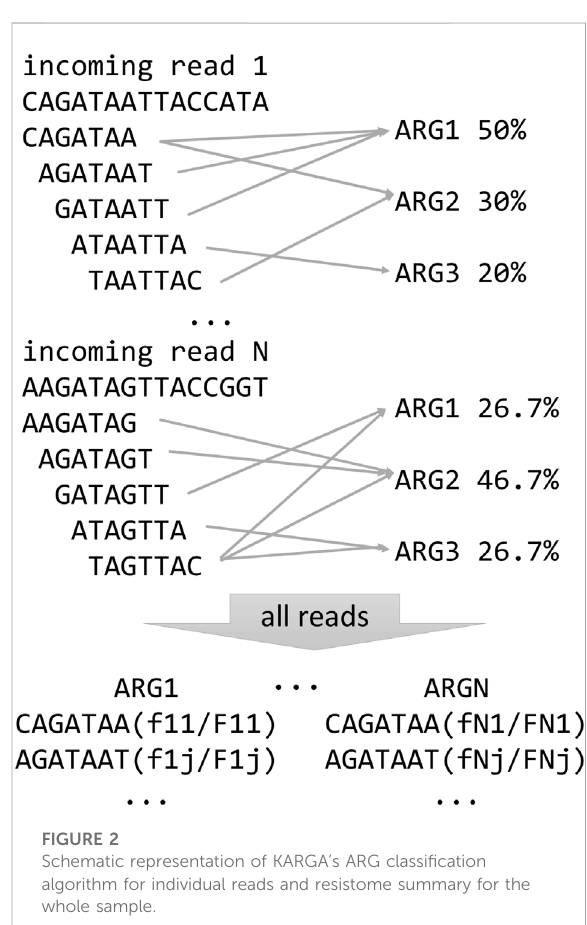
FIGURE 2 Schematic representation of KARGA ’ s ARG classi fi cation algorithm for individual reads and resistome summary for the whole